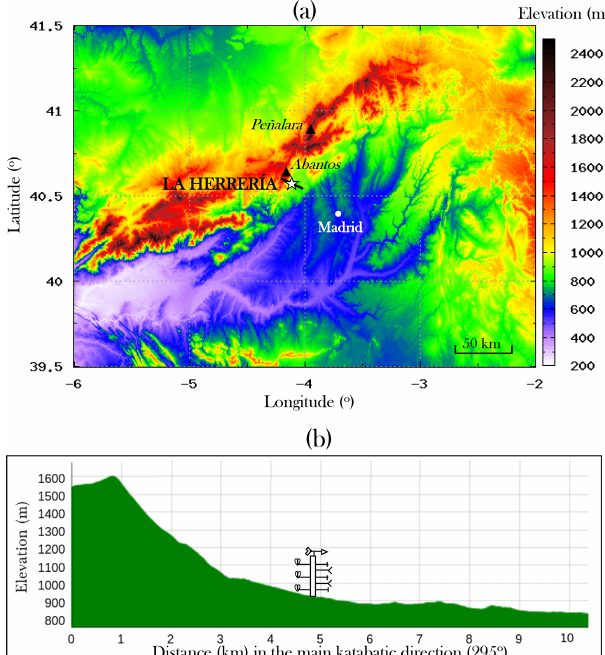
Figure 1. (a) Topography of the area surrounding the La Her- rería site, which is indicated with a star. The positions of the city of Madrid, along with the Abantos (1763m) and Peñalara peaks (2420m), are additionally pointed out. The black line shows the cross-section along the main downslope direction from La Herrería, represented below. The source of topography data is the Shuttle Radar Topography Mission (SRTM) 90m digital elevation model (DEM) (http://srtm.csi.cgiar.org/, last access: 14 March 2019). (b) Topographical profile along the cross-section indicated by the black line (obtained from